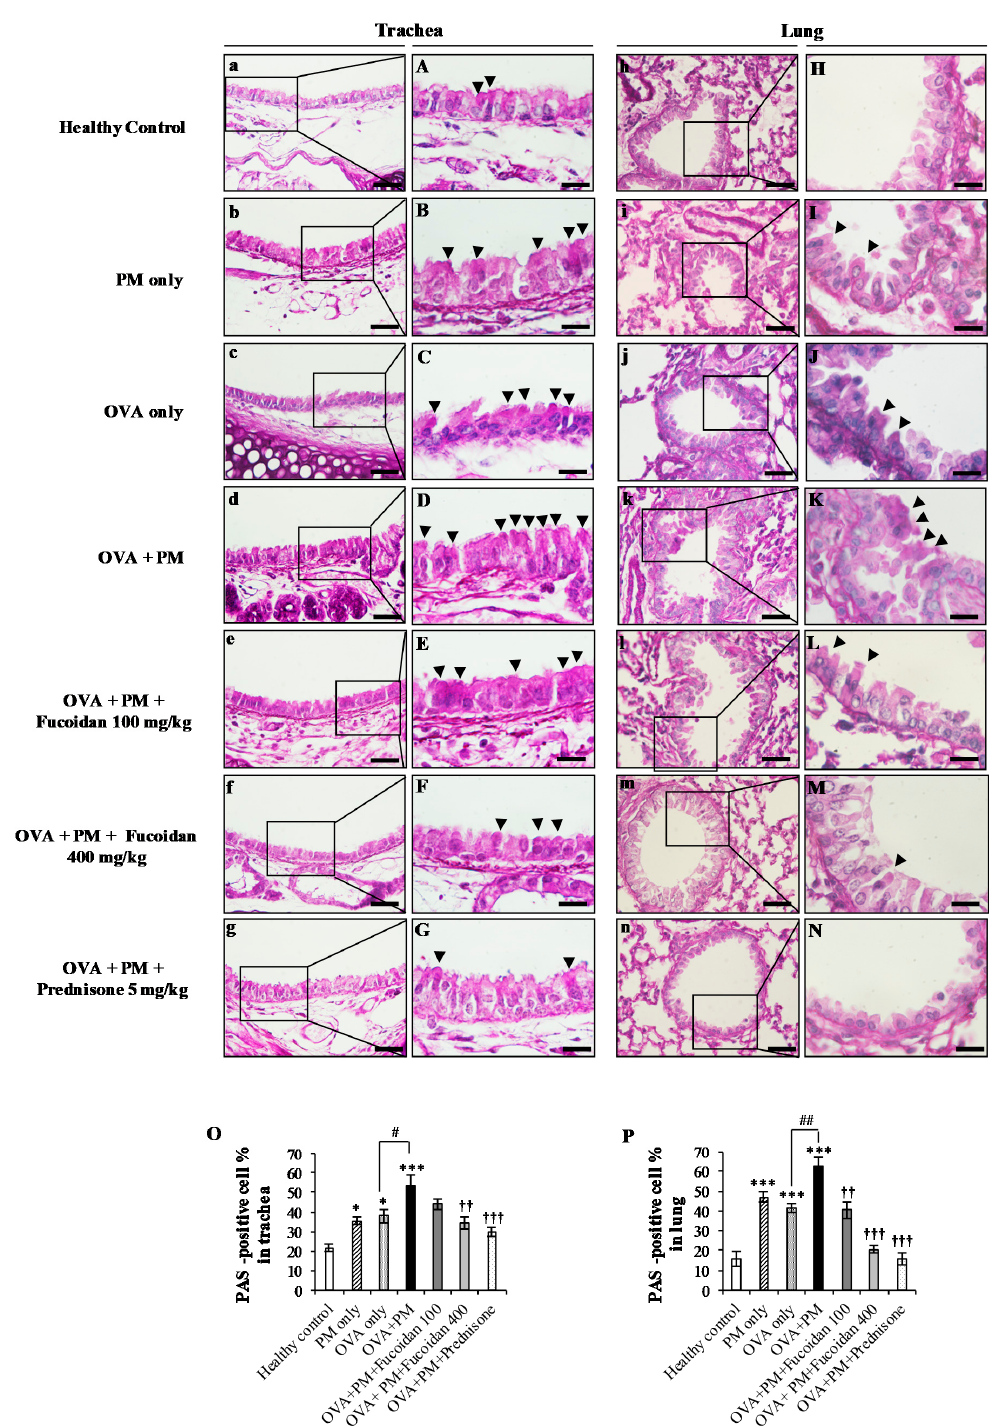
Figure 10. The e ff ect of fucoidans on PAS-positive goblet cells in ( a – g , A – G ) the trachea and lungs ( h – n , H – N ) of PM-exposed mice. PAS-positive cell percentage in ( O ) the trachea and ( P ) the lungs are shown. Arrowheads indicate the mucus secreting goblet cells. Values are expressed as means ± SEM ( n = 3). * ( p < 0.05), *** ( p < 0.0005) represent significant increases compared with the healthy control, and †† ( p < 0.005), ††† ( p < 0.0005) represent significant decreases compared with the OVA + PM group. # ( p < 0.05), ## ( p < 0.005) represent significant increases compared with the OVA only group. The scale bar of ( a – g ) and ( h – n ) is 25 µ m. The scale bars of ( A – G ) is 25 µ m, and ( H – N ) were captured by an oil immersion lens (magnification ×